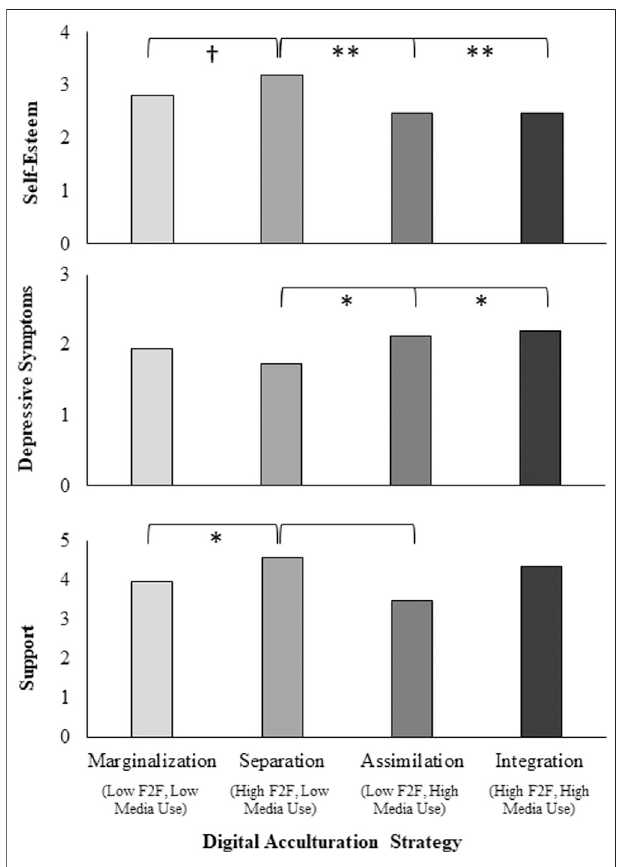
FIGURE 2 | Differences Across Digital Acculturation Strategies for Self- Esteem, Depressive Symptoms, and Support.